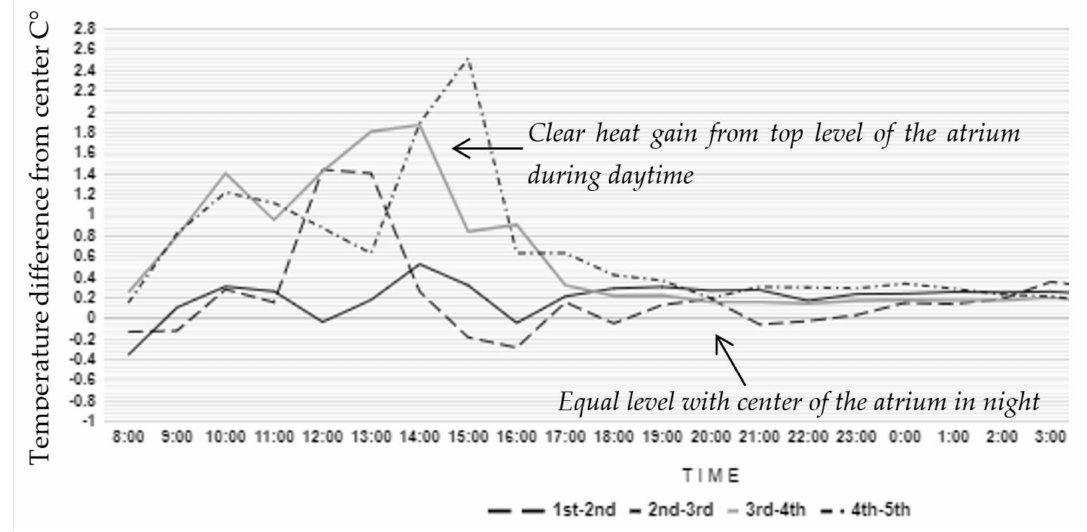
Figure 12. Elevation of air temperature in the perimeter zones of the atrium from its corresponding centers along 1st to 5th floor levels creates a heat gain risk on the adjacent o ffi ce